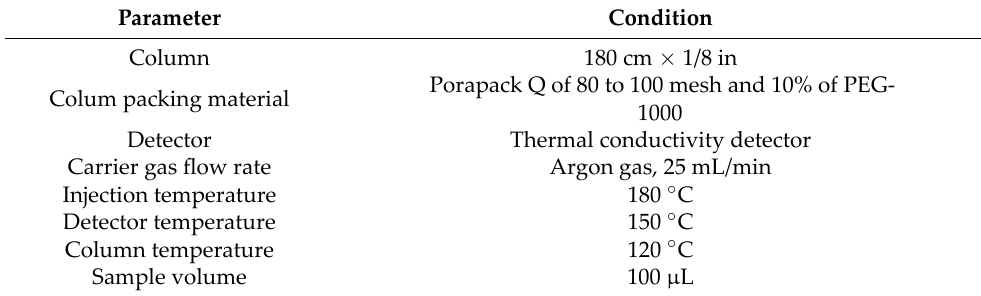
Table 6. The operating conditions used for GC